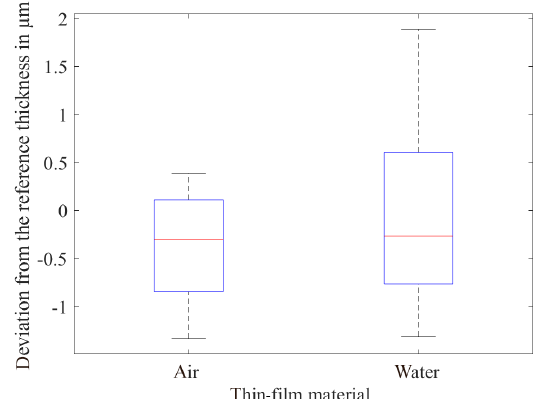
Figure 9. Deviation of the layer thicknesses in relation to the geo- metric